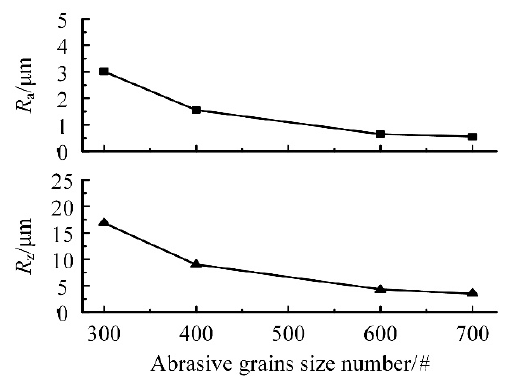
ff ect of abrasive grains size on surface Figure 6. Effect of abrasive grains size on surface roughness. Figure 6. E